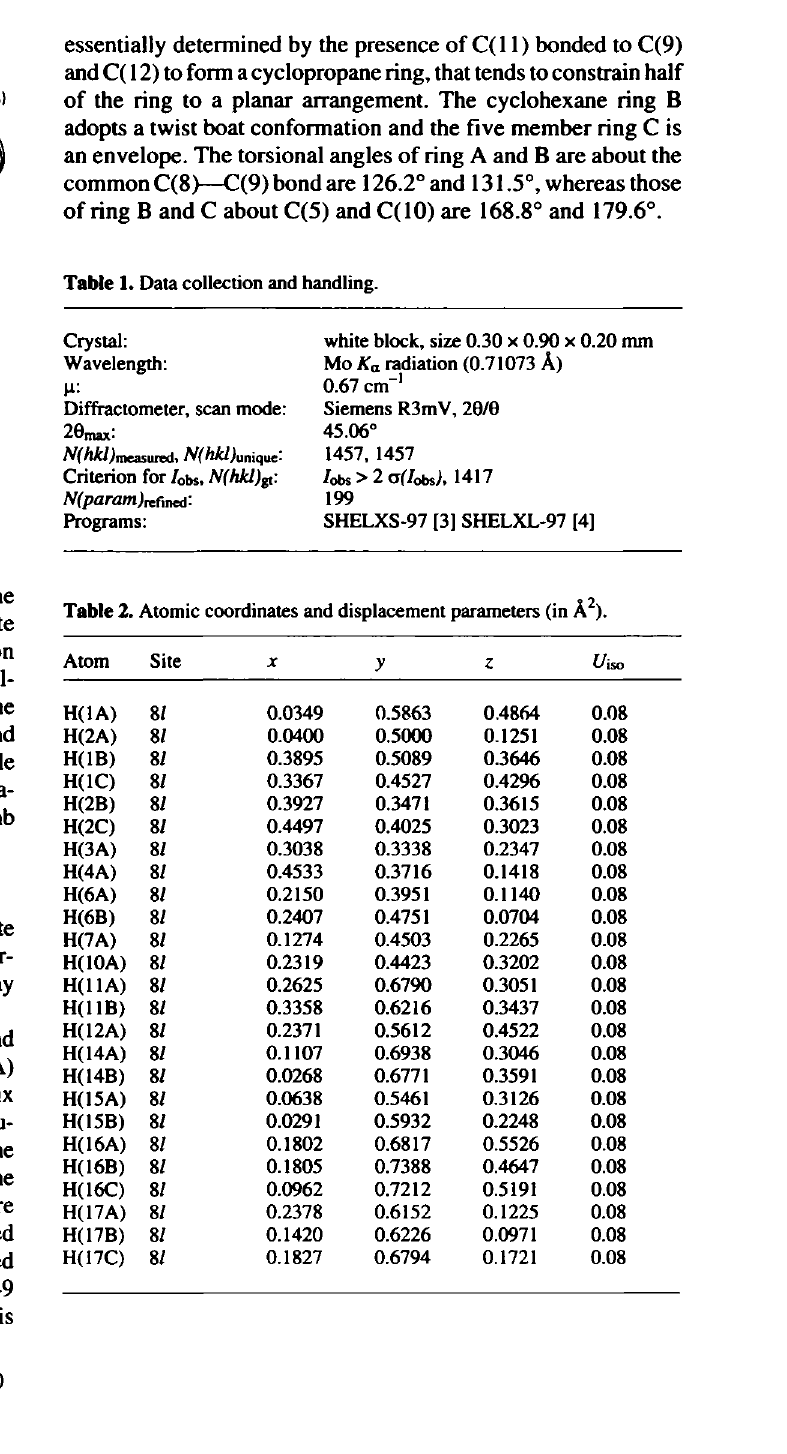
Table 1. Data collection and handling.